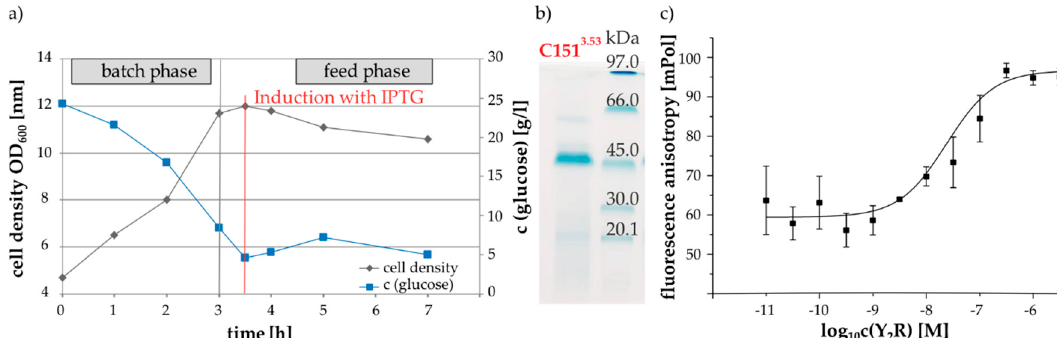
Figure 4. Sample preparation of Y 2 R mutants: ( a ) exemplary curves of the cell density during cultivation and glucose consumption in an E. coli fed-batch-fermentation for recombinant expression of the Y 2 R_ ∆ 5Cys_C151 3.53 mutant; ( b ) SDS gel of the solubilized and purified Y 2 R_ ∆ 5Cys_C151 3.53 mutan; ( c ) characterization of ligand binding of the Y 2 R_ ∆ 5Cys_C151 3.53 in bicelles using a fluorescence polarization assay with TAMRA-NPY [34]. Based on the saturation curve a K D -value of 25 nM was determined.